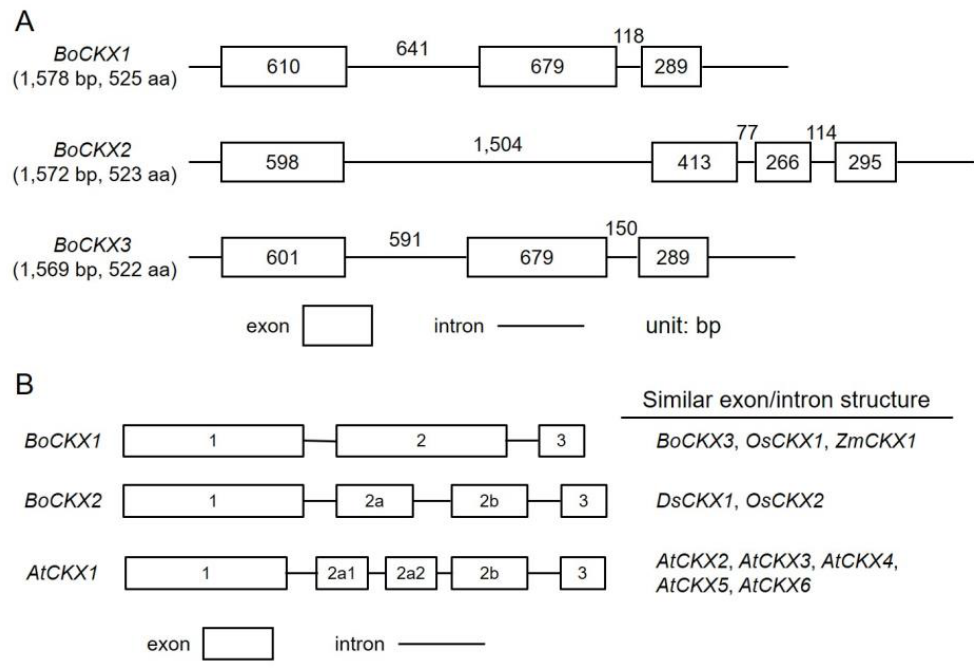
Figure 2. Exon-intron organization of Bamboo CKX genes. Introns (lines) and exons (rectangles) were graphed to scale, along with the number of base pairs (bp). Sequences compared ( A ) were isolated from Bambusa oldhamii ( BoCKX1 , GU263785; BoCKX2 , GU263786; and BoCKX3 , GU263787). Exon-intron structures of the CKX genes were compared among different species ( B ).